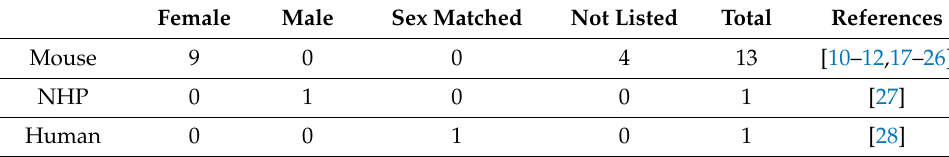
Table 1. Research subject sex in published research articles with